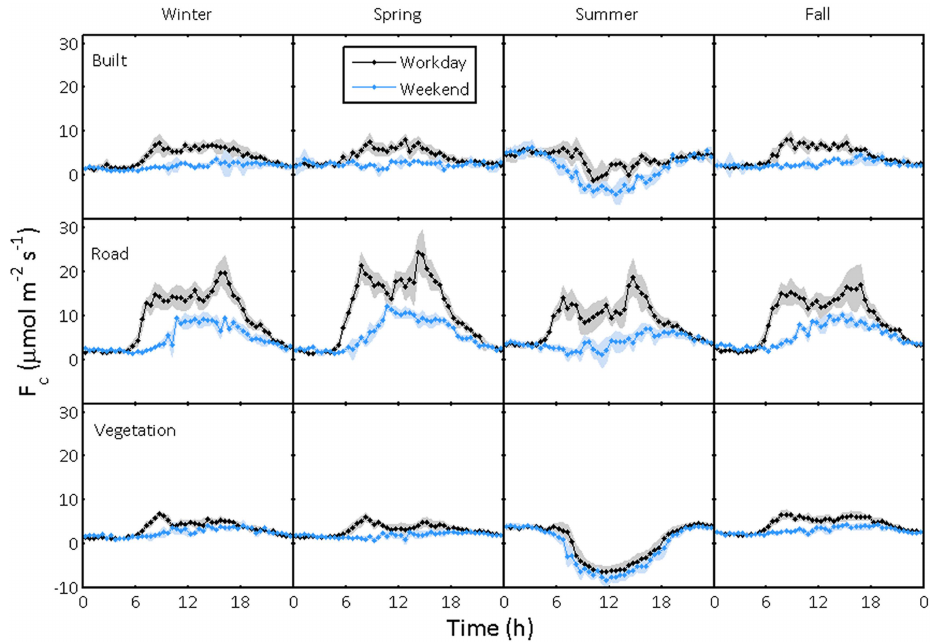
Fig. 6. Median diurnal variation of the CO 2 flux ( F c ) for different surface cover areas in each thermal season. Separation to weekdays (black dotted line) and weekends/holidays (blue dotted line) was also made. Shadowed areas show the quartile